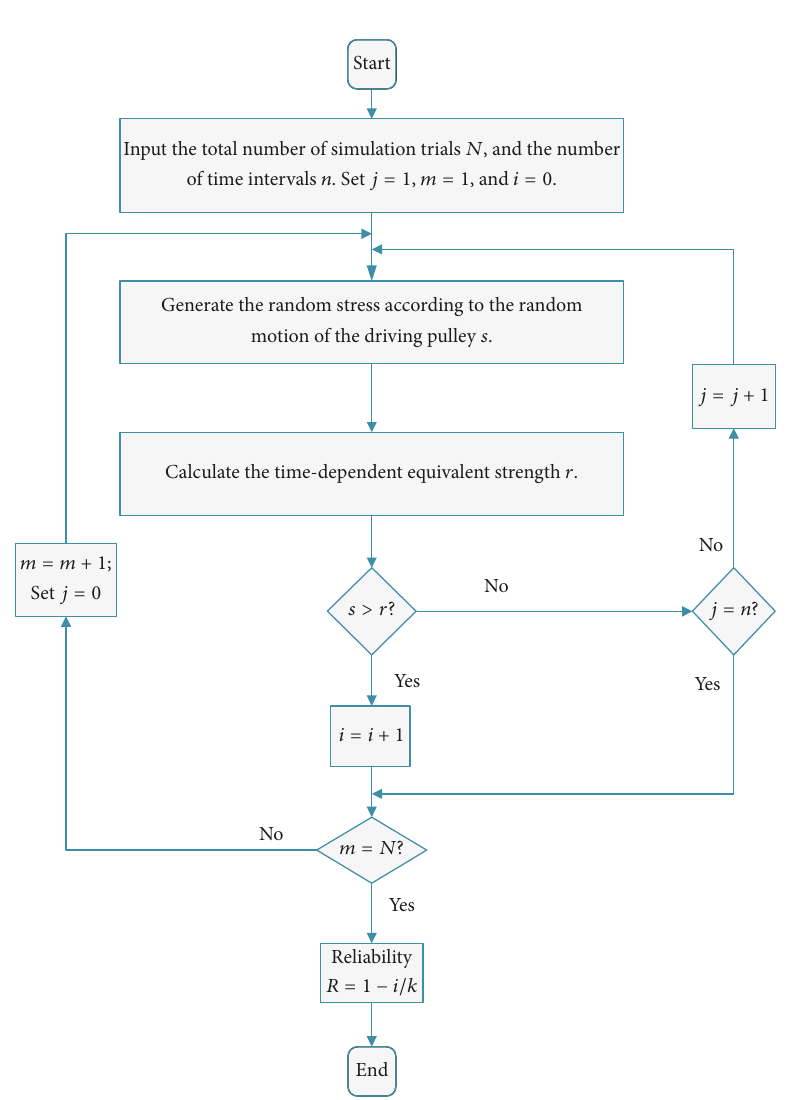
Figure 3: Monte Carlo